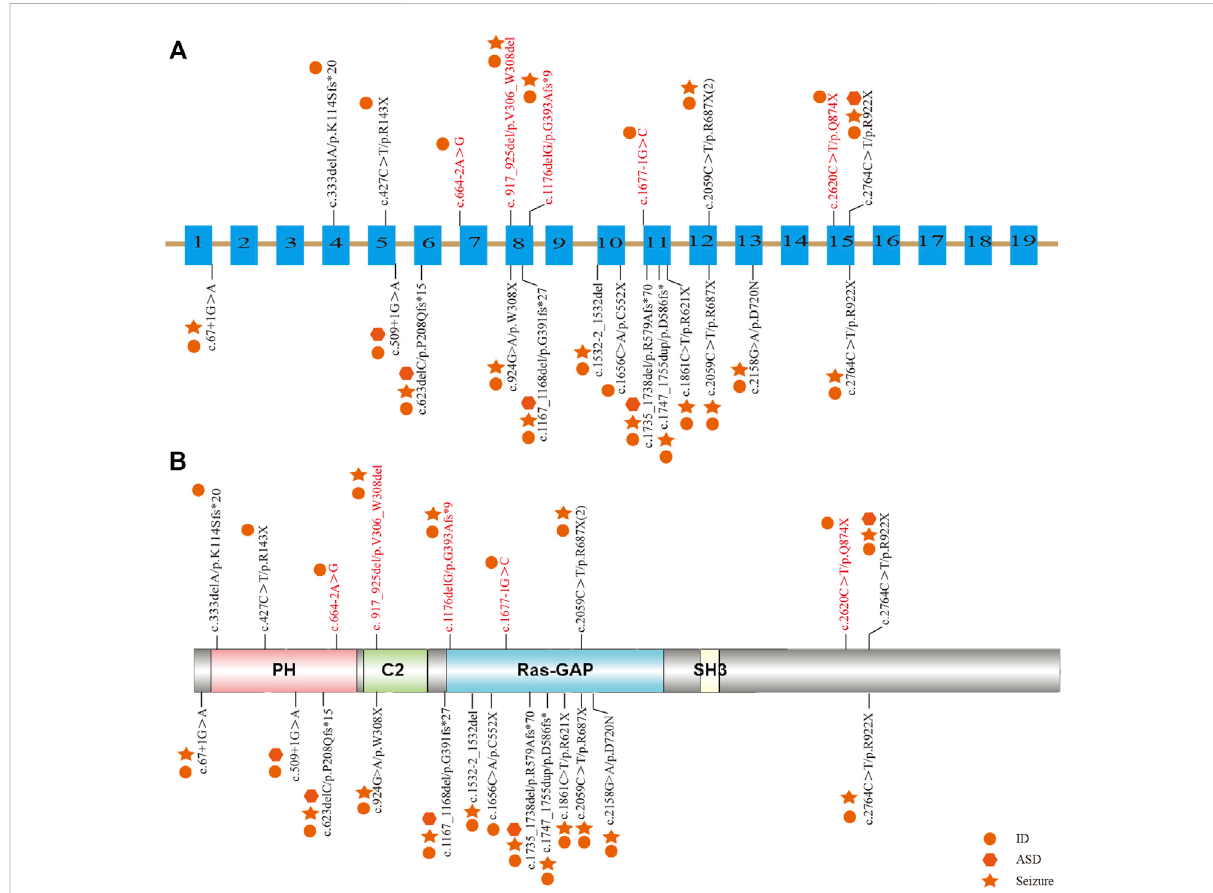
FIGURE 1 Distribution of mutations in Chinese patients among different exons and domains. The mutations in our study are listed prior to the exons or domains, in which fi ve novel mutations are marked in red. The other mutations from previous studies in China are listed beneath the exons or